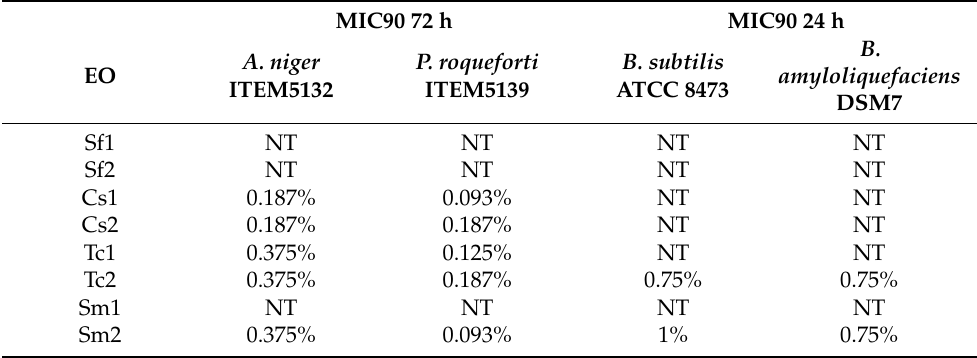
Table 7. MIC values of EOs against fungal ( A. niger ITEM5132 and P. roqueforti ITEM5139)